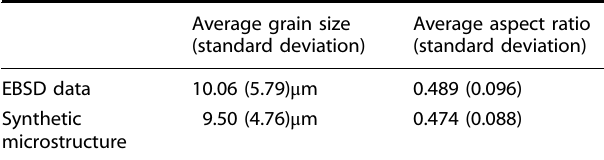
Fig. 1 Comparison between experimental ( black ) and synthetically generated ( white ) microstructural features: a grain size distribution; b grain aspect ratio; c misorientation distribution. The experimental and synthetically generated microstructures are visualized in d and e , respectively Table 1. Average grain sizes and aspect ratios measured from the experimentally observed and synthetic